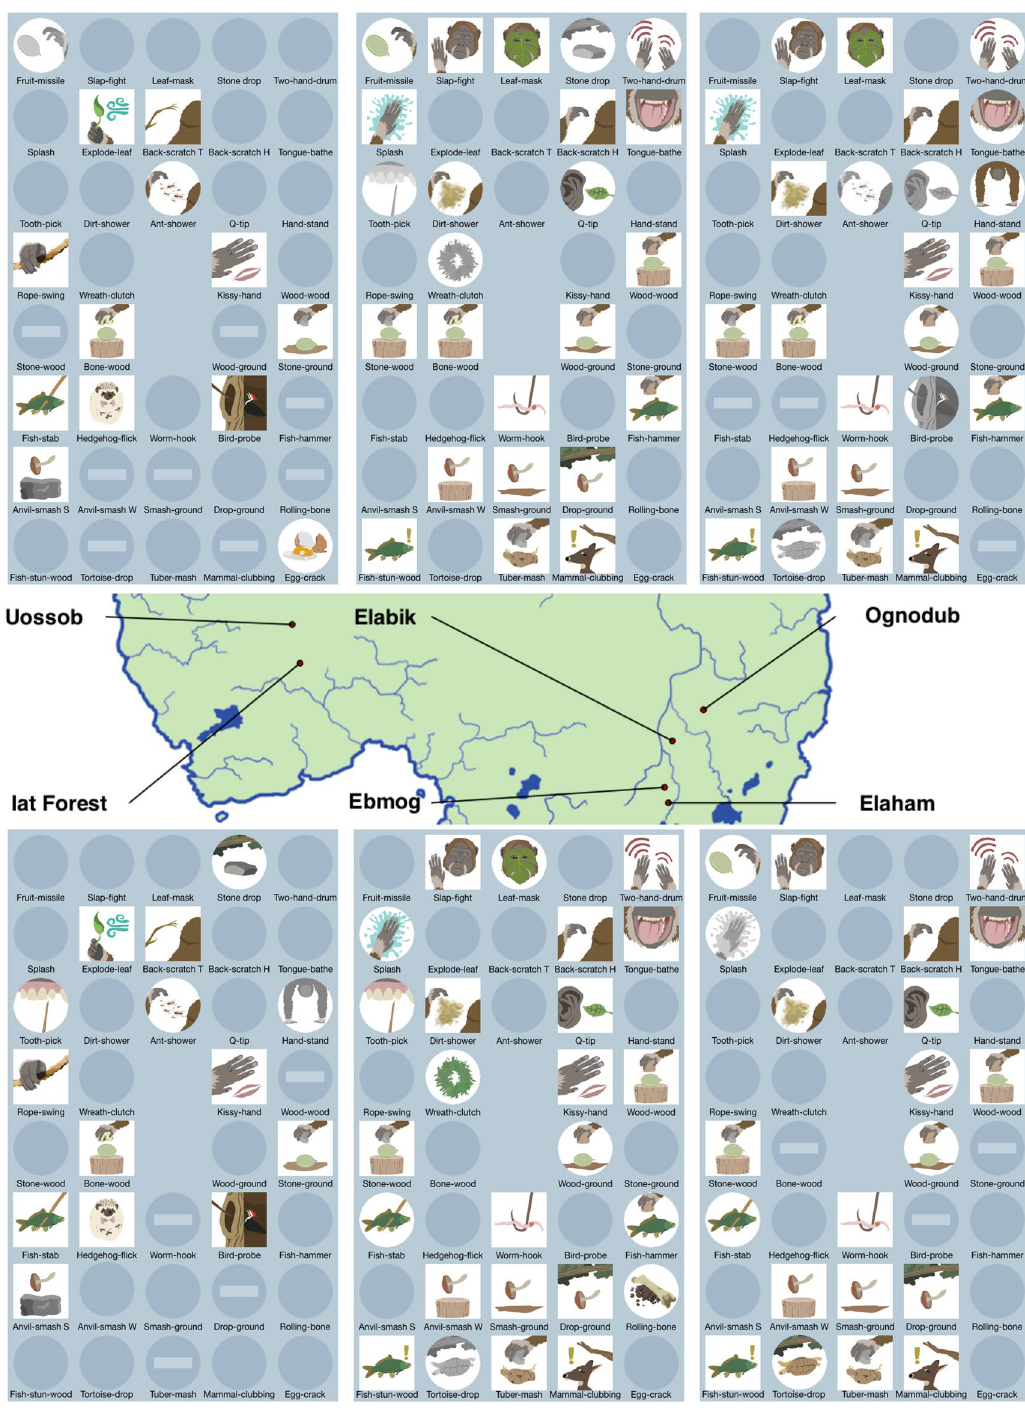
Figure 2. Example of a simulation run that produces 38 cultural traits ( S = 1 , α e = 0.8 , and α g = 0.2 ). Color icons indicate customary behaviours; circular icons, habitual; monochrome icons, present; clear, absent; horizontal bar, absent with ecological explanation. The names of the behaviours are only evocative, see SI for a complete list. (The map was created using the software R (https://www.r-project.org ) and with artwork from